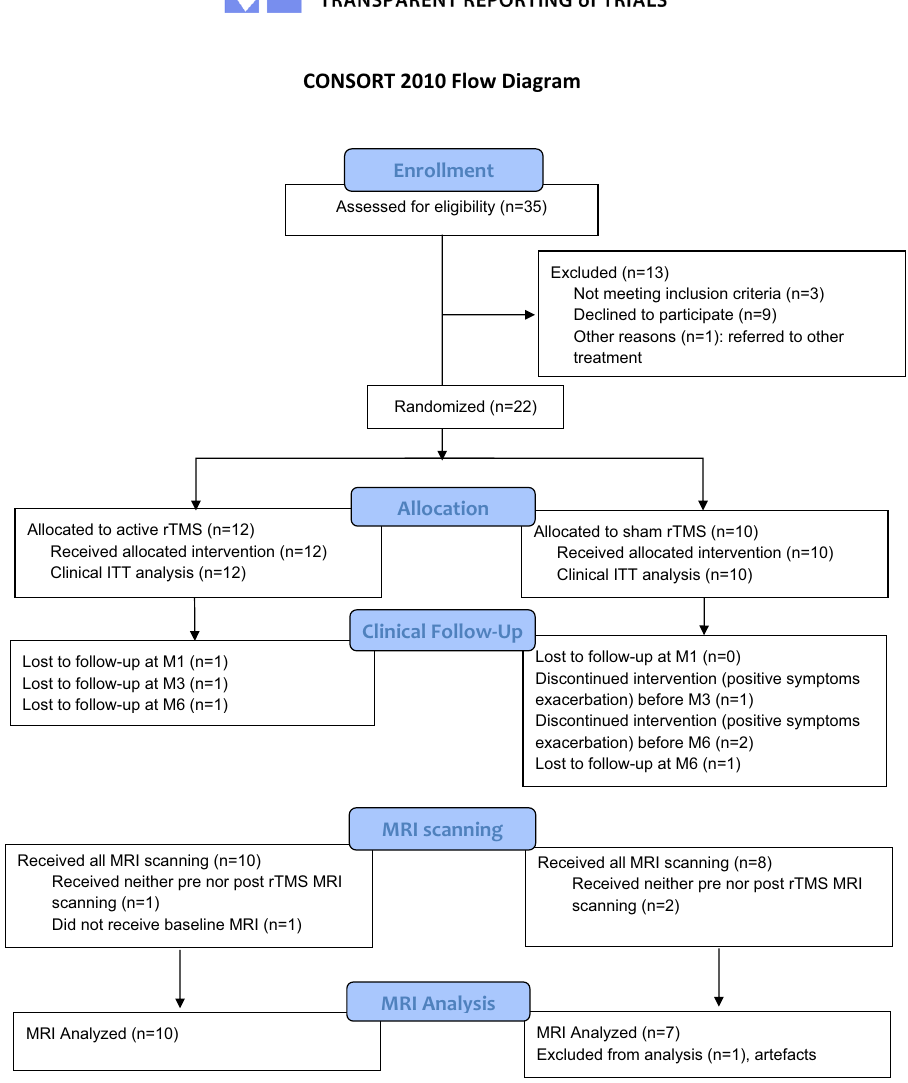
Fig. 3 Patients selection. CONSORT fl ow chart diagram of the